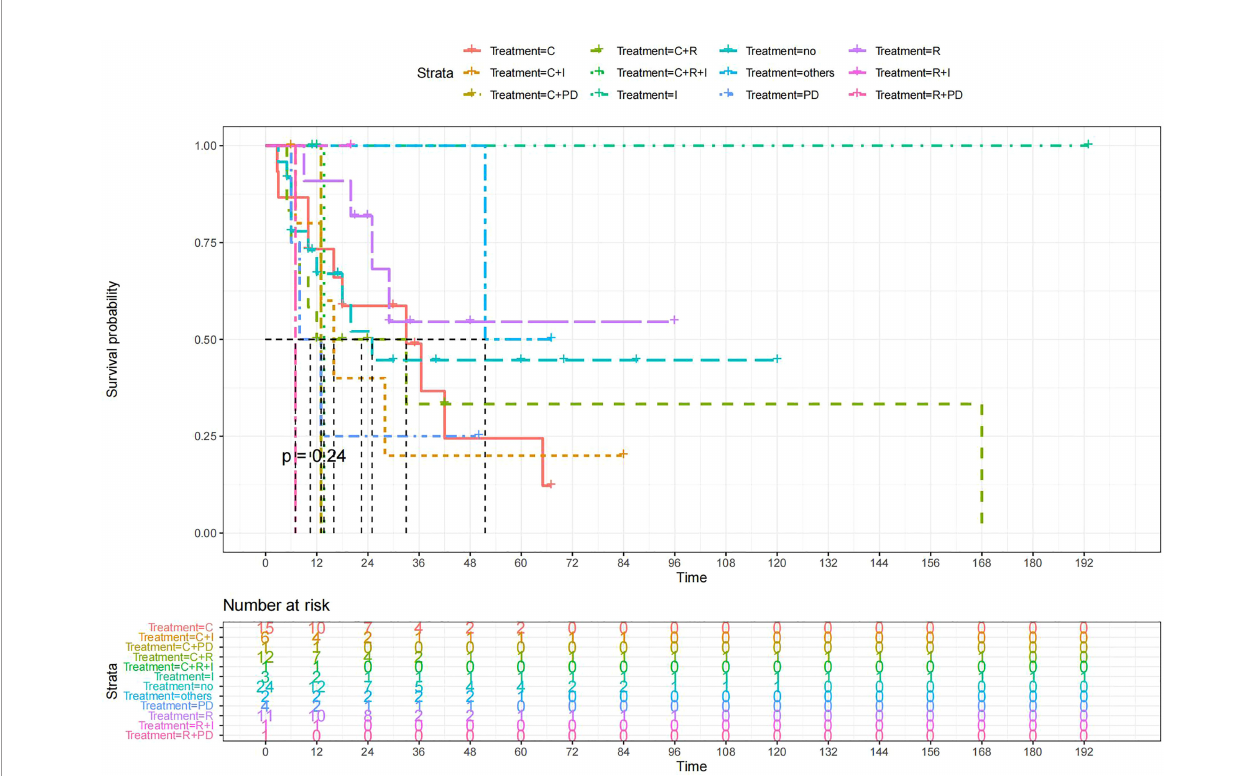
FIGURE 8 | Kaplan-Meier survival curves for OS in patients of surgery (RH+TAH) plus various treatments vs. no other treatments. The median OS was signi fi cantly longer for patients who added chemotherapy and other treatments(oncolytic virus Rigvir ® , argon laser, Argon heliumknife) than for those who added the remaining treatment modalities (Except for radiotherapy, Survival rates of this group at the 54m time point were higher for patients than other groups.) C: chemotherapy R: radiotherapy I: immunotherapy (interferon- g or interleukin-2) PD : PD-1/PD-L1 Others: oncolytic virus Rigvir ® , argon laser, Argon heliumknife+Sunitinib no:no other treatment.